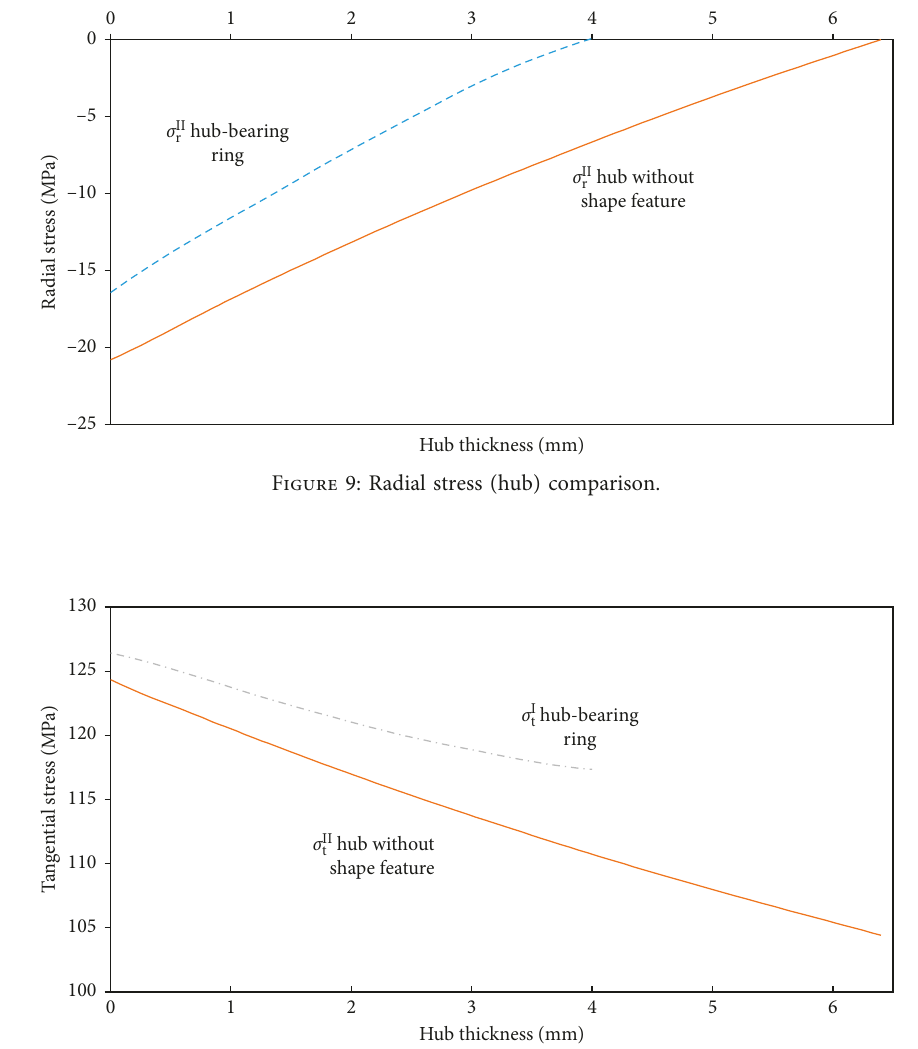
Figure 10: Tangential stress (hub) comparison.